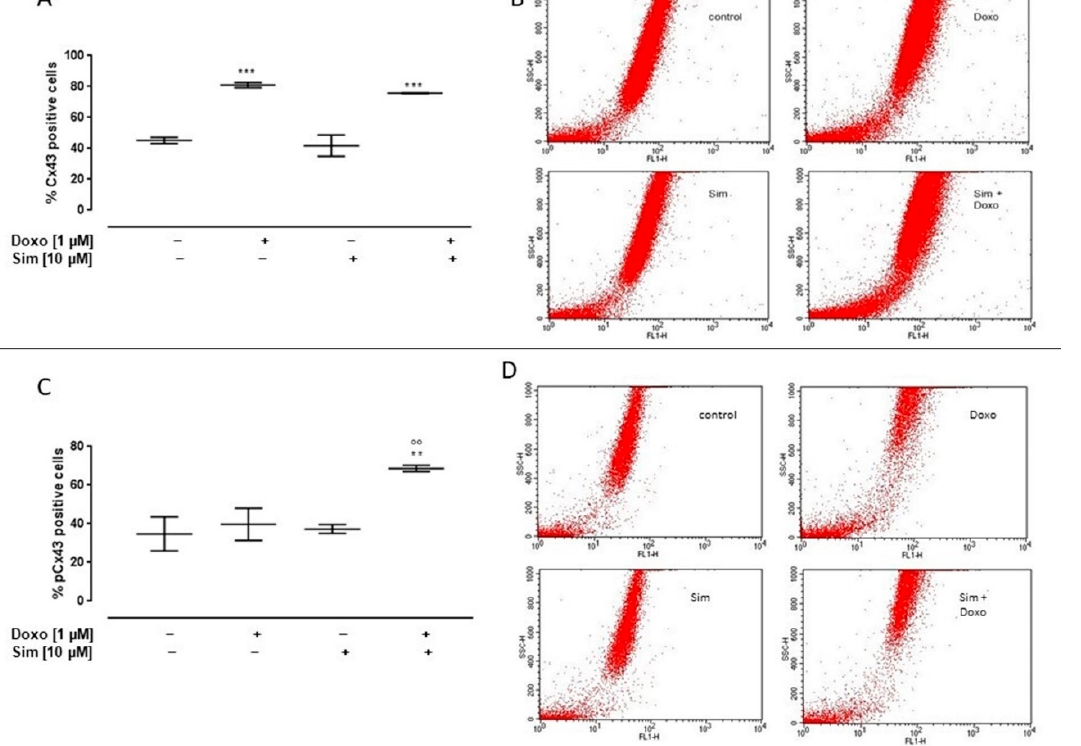
Figure 5. Effect of Simvastatin on membrane levels of Connexin43 and Connexin43 phosphorylated on Ser368. H9c2 cells were pre-treated with Sim (10 µM) for 4 h and then co-exposed to Sim and Doxo (1 µM) for 20 h. Cx43 ( A ) and pCx43 ( C ) levels were detected by flow cytometry analysis. Results are reported as mean ± S.E.M. of Cx43- and pCx43-positive cells’ percentage from at least three independent experiments, each performed in duplicate. Representative histograms for the flow cytometry analysis are reported in Panels ( B , D ), respectively. Data were analyzed by variance test analysis, and multiple comparisons were made by Bonferroni’s test. ** p < 0.005 and *** p < 0.001 vs. untreated cells; °° p < 0.005 vs. Doxo-treated cells.